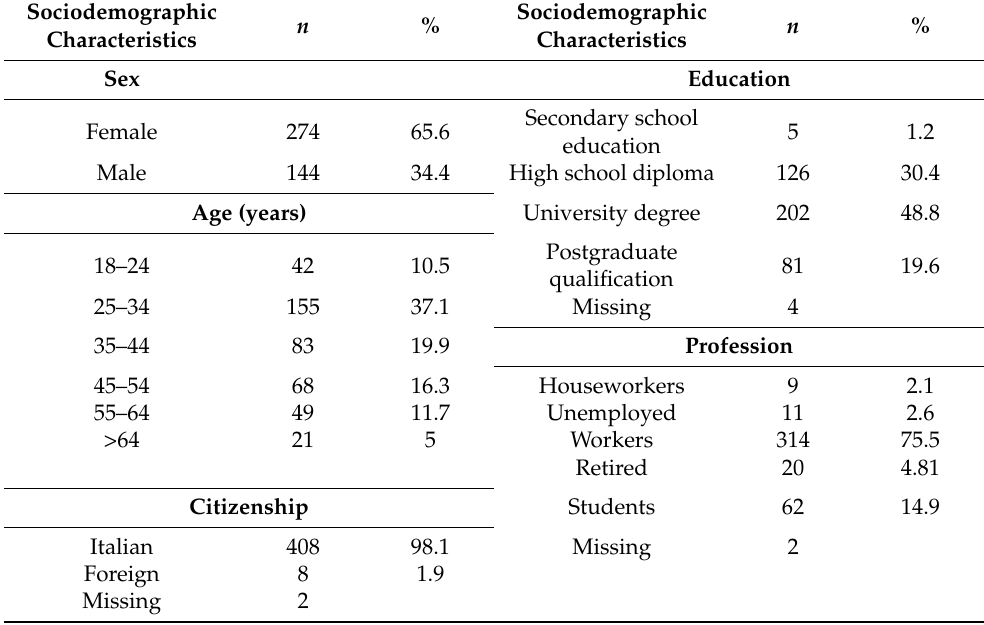
Table 1. Socio-demographic characteristics of the study population.